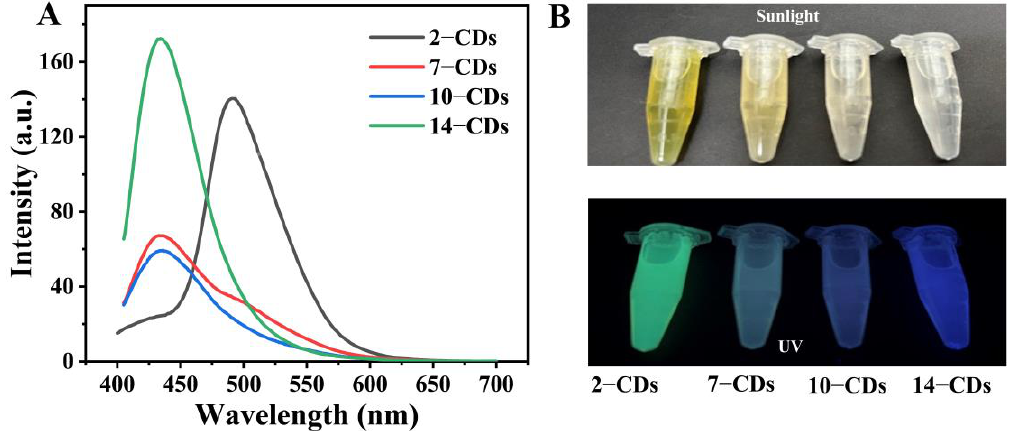
Figure 2. ( A ) Fluorescence emission spectra of the 2 −CDs, 7−CDs, 10−CDs and 14− CDs. ( B ) Digital photo of th e 2−CDs, 7−CDs, 10−CDs and 14− CDs in sunlight and under UV